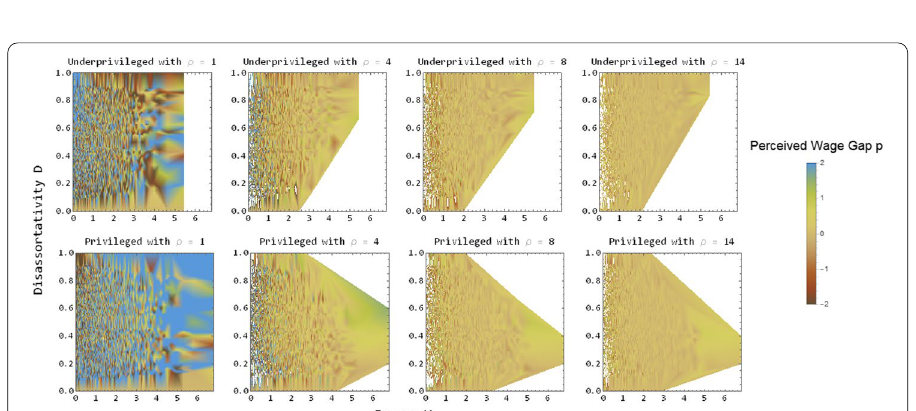
Fig. 5 Heatmap of wage gap perceptions (as a ratio to the correct wage gap g ) for varying privilege, disassortativity D (rate of links to the other privilege class) and income Y for g = 0.2 and varying actual wage gaps ρ ∈ { 1 ; 4 ; 8 ; 14 } . Upper panels for the underprivileged agents, lower panels for the privileged